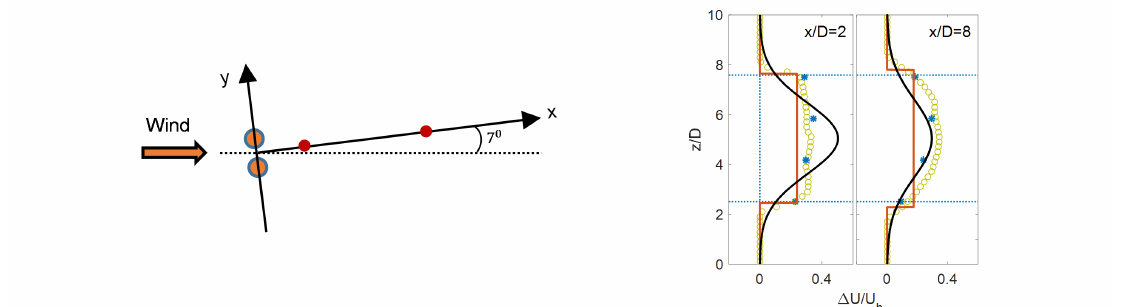
Figure 6. Schematic of the two turbines immersed in the flow (red circles are the measurement locations) ( left ), and wall-normal profiles of the normalized velocity defect ( right ) for Case (5). The LES (open circle) and field measurement (asterisk) data were extracted from Hezaveh et al. [42].